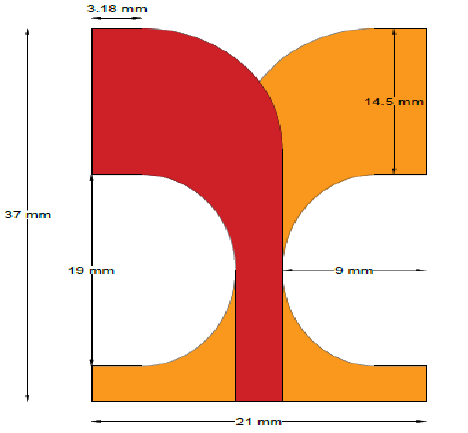
FIGURE 2. Basic Antipodal Vivaldi